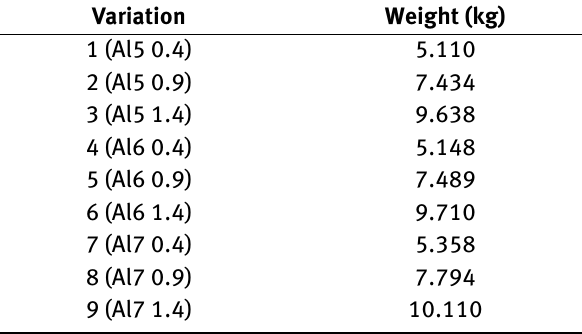
Table 8: List of the chassis